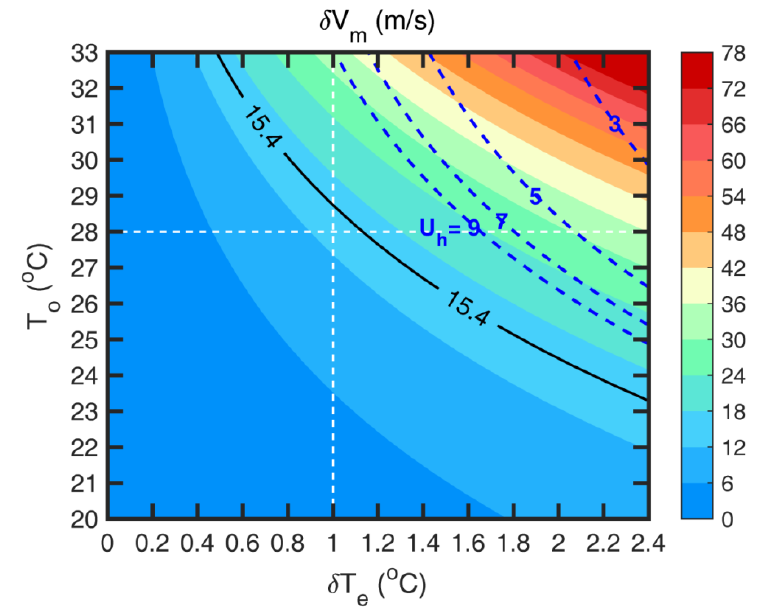
Figure 8. Colour shading: maximum possible intensity change δ V m due warm-eddy δ T e warmer than the ambient SST T o . White dashed lines show the ( δ T e , T o ) values observed in the western North Pacific RI region and used in the WRF-POM model: eddy with δ T e 1 °C warmer than the ambient T o = 28 °C. Blackline shows the δ V m = 15.4 m/s contour separating RI on the upper right from non-RI on the lower left. The blue dashed lines do not correspond to the colour shading. Instead, they show the δ V m = 15.4 m/s contours of the analytical coupled model accounting for ocean cooling at different translation speeds U h = 9, 7, 5 and 3 m/s. For very fast U h , the blue dashed line tends to the black 15.4 m/s line. The ocean has two layers with equal thickness = 100 m. This figure includes the second-order term in the analytical model. See Appendix A.